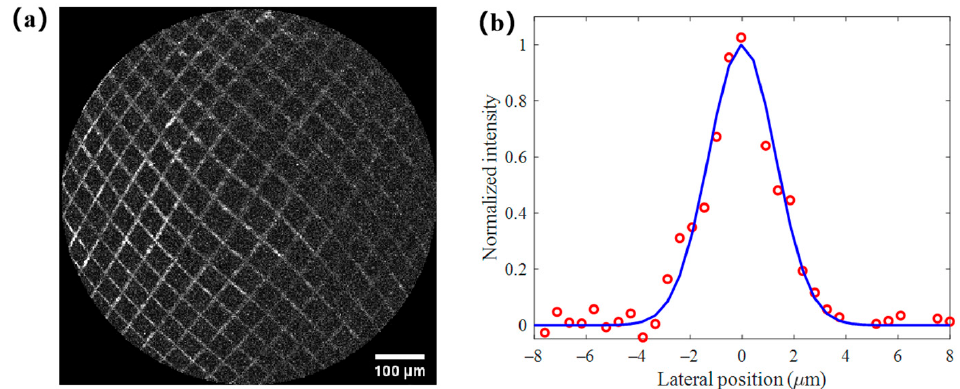
Figure 7. ( a ) Two-photon imaging of a 50 µm square standard grid for FOV measurement. Scale bar: 100 µm; and ( b ) Two-photon imaging lateral resolution measurement. Red circle: measured data; Blue line: Gaussian fi t.